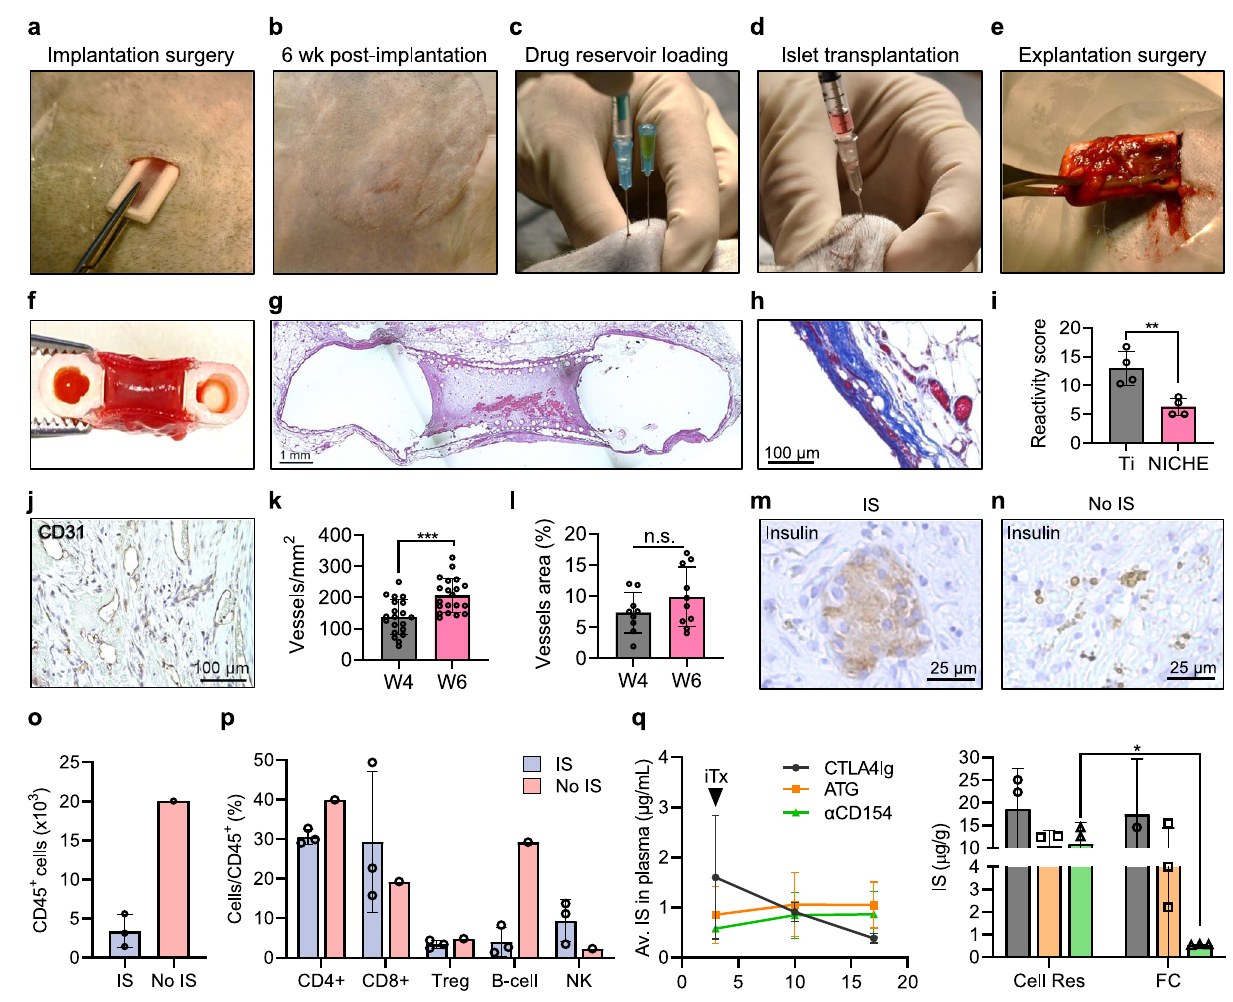
Fig. 6 | NICHE biocompatibility, islet engraftment, and local immunomodula- tion in NHP. a – e NICHE deployment strategy in nonhuman primates (NHPs). f Gross and g H&E-stained micrograph showing a cross-section of NICHE after 4 weeks of subcutaneous implantation in NHP. h Masson ’ s Trichrome staining of fi brotic capsule formed around NICHE after 4 weeks of subQ implantation in